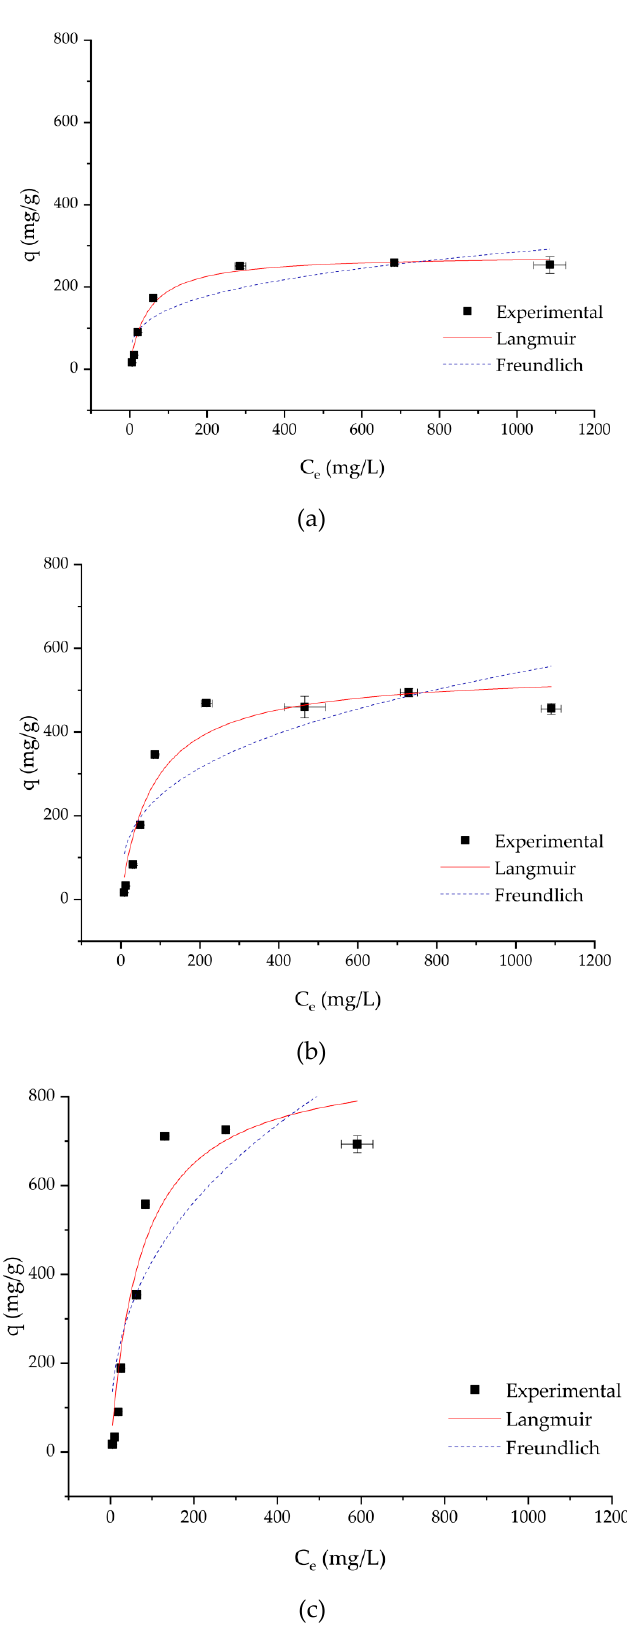
Figure 6. Adsorption isotherms at pH = 3: ( a ) DCMC 1, ( b ) DCMC 2, and ( c ) DCMC 3.